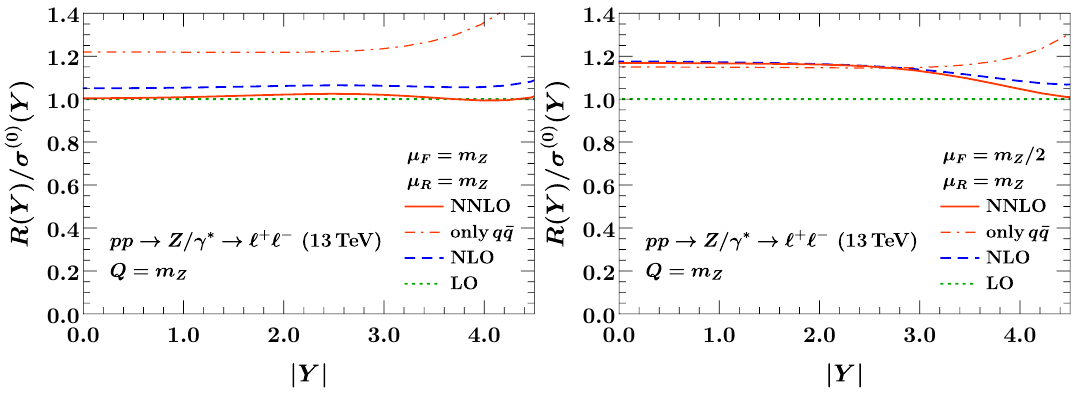
Figure 9 . The perturbative remainder R ( Y ) for pp ! Z=(cid:13) (cid:3) ! ‘ + ‘ (cid:0) , normalized to (cid:27) (0) ( Y ) (cid:17) d 2 (cid:27) (0) = d Q d Y at Q = m Z for (cid:22) F = m Z (left) and (cid:22) F = m Z = 2 (right). The dot-dashed line shows the result including only the q (cid:22) q